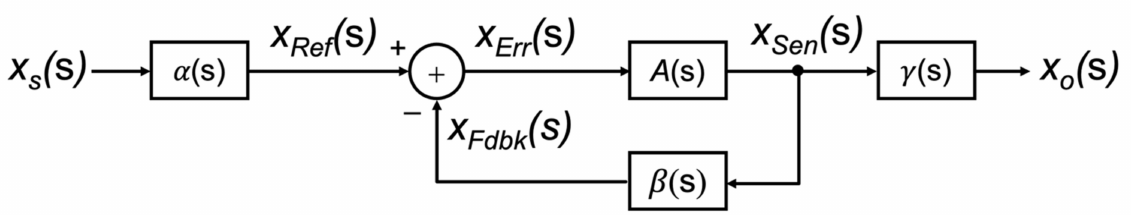
Figure 10. Inclusion of a feed-in branch α (s) to expand the circuit range of applicability of a single- loop negative feedback system